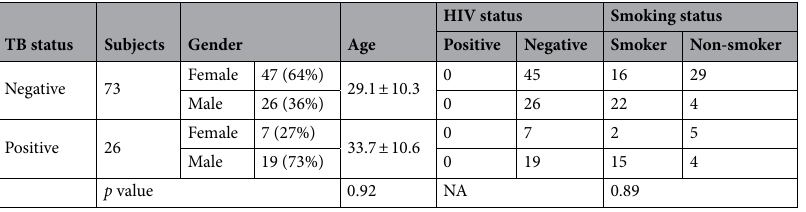
Table 1. Study participant information.